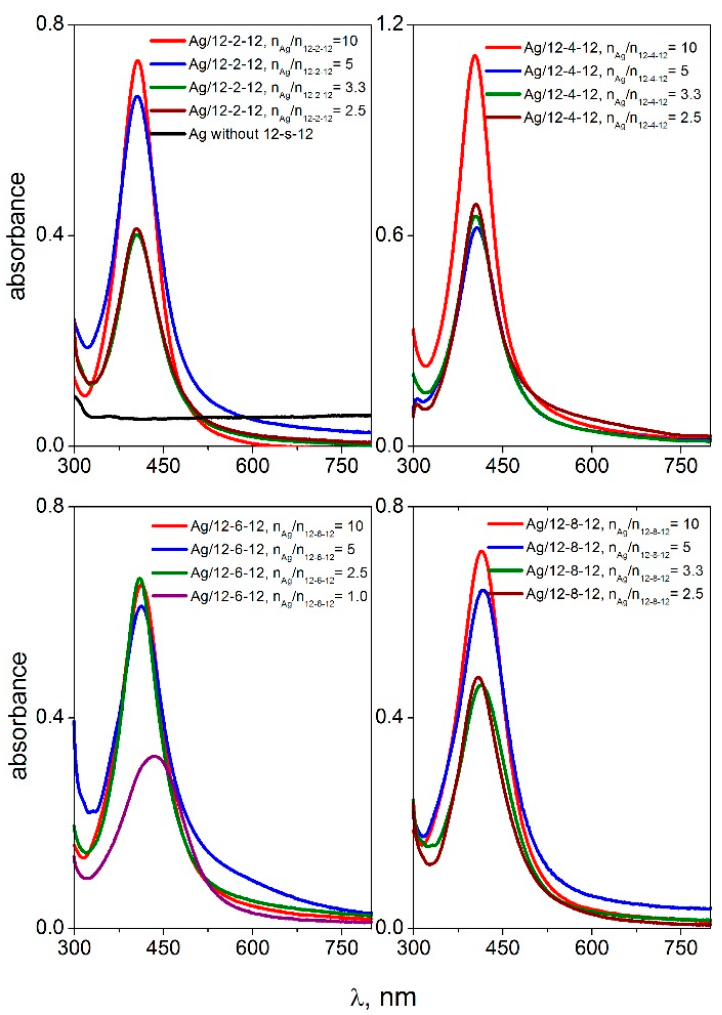
Figure 1. UV-VIS spectra of silver nanoparticles stabilized with gemini surfactants 12- s -12 with the spacer length s = 2, 4, 6, 8 methylene groups, at different molar ratio values n Ag /n 12- s -12 .